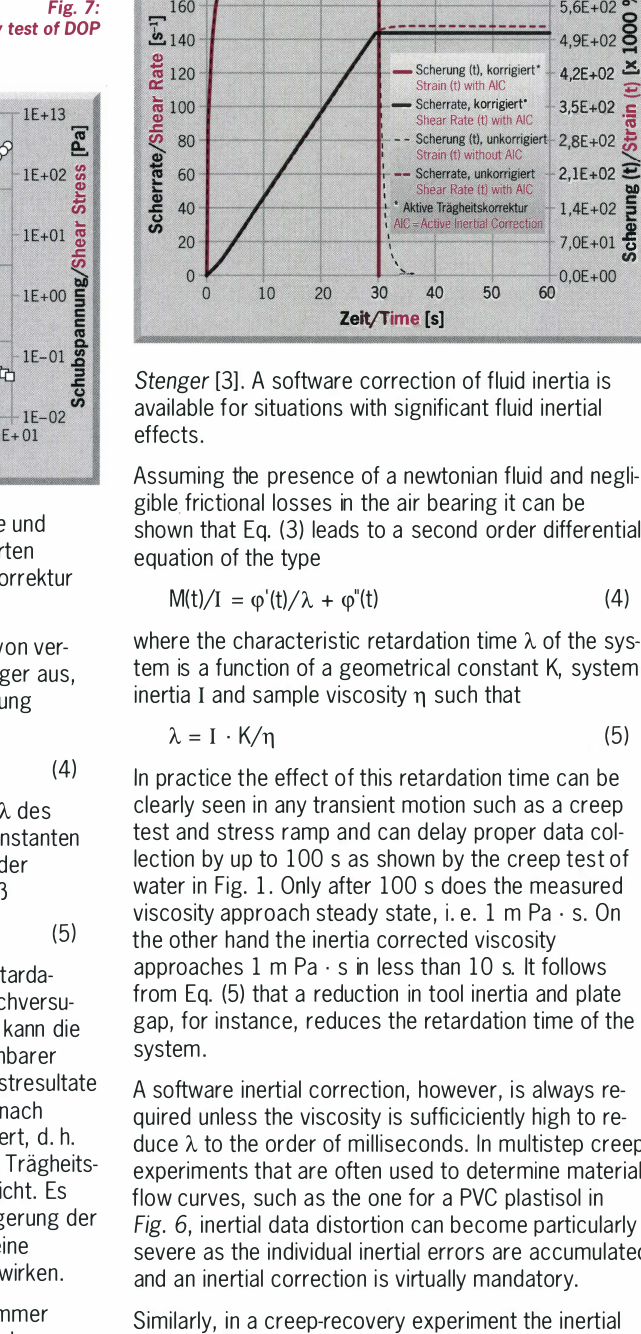
Creep-recovery test of